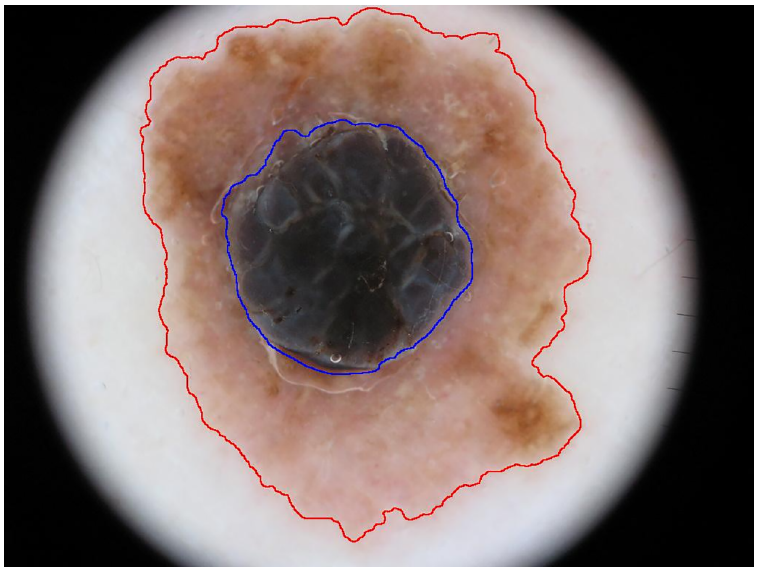
Fig 1. Segmentation by different methods. Blue line: automatic segmentation. Red line: manual segmentation. Image ISIC_000276 of the ISIC Archive, sharedunder the CC-0 license.